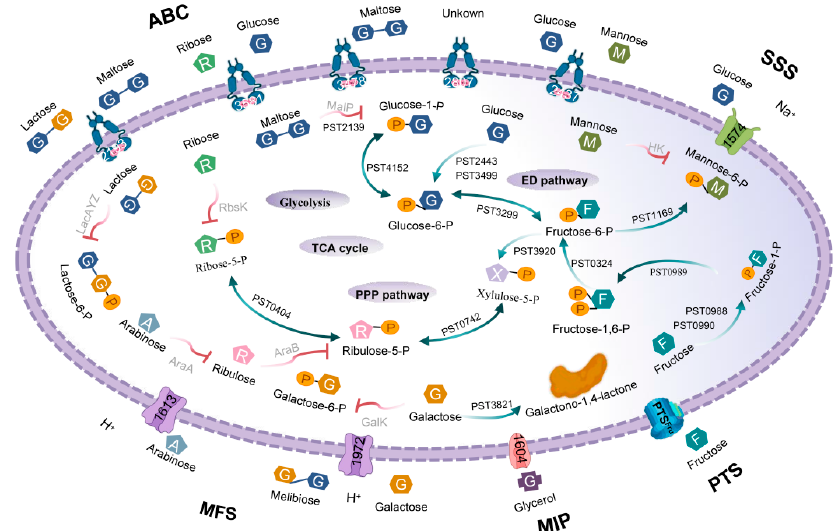
Figure 2. The substrate and metabolic pathways of the inferred sugar-transport system in P. stutzeri A1501. Detailed gene annotation is provided in Figure S3.